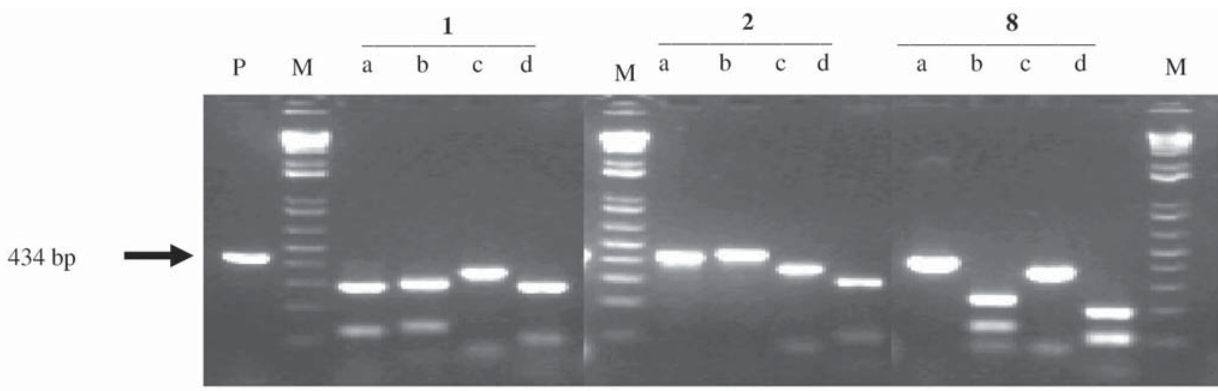
Fig. 2. RFLP patterns of ( 1 ) Ecc CFB 2046; ( 2 ) DPP Pu6, DPP Pu7, DPP Pu8, DPP As–1, DPP As–14; ( 8 ) Ecc EII 354– 86, DPP As–2, DPP As–3 PCR amplification product, obtained with primers Y endonucleases Alu I, Hae II, Hpa II and Sau 3A I. M, 1 kb marker (Invitrogen); P, amplification product of 434 bp; a , Alu I; b, Hae II; c, Hpa II; d, Sau 3A